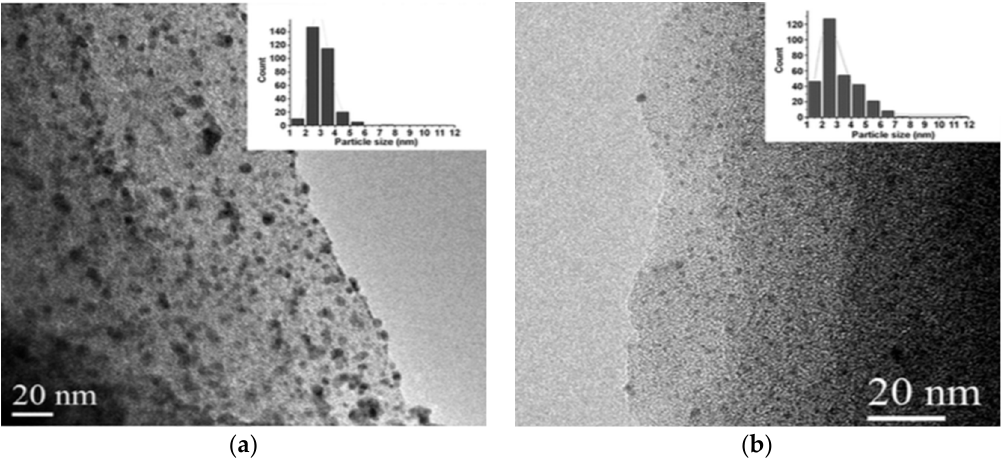
Figure 1. TEM images of Pd PVA /CTF ( a ) and Pd IMP /CTF ( b ). Insets: Particle size distributions of the Pd NPs (Reproduced with permission from [29]. Copyright 2015, Wiley-VCH).